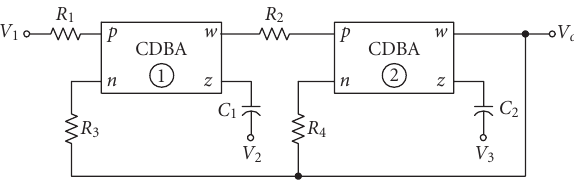
Figure 3: Proposed CDBA-based universal biquad